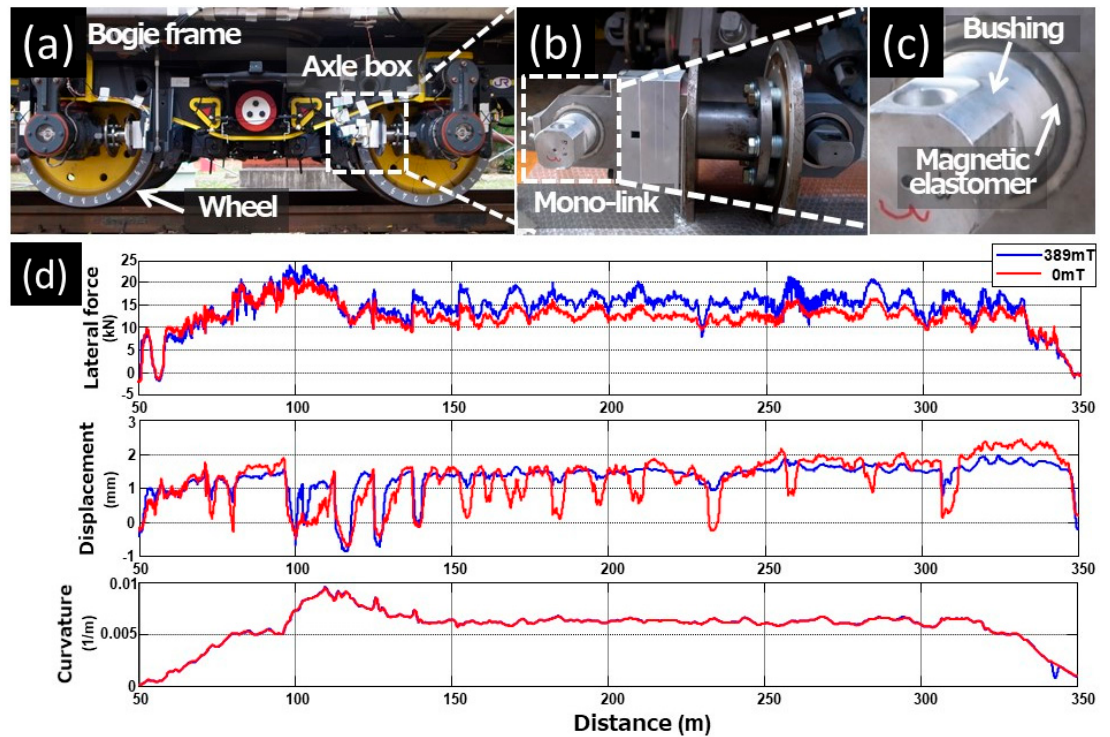
Figure 4. Photographs of ( a ) bogie and ( b , c ) mono-link made of magnetic elastomer containing LP+NP, ( d ) lateral force ( top ), displacement of the magnetic elastomer bushing ( middle ), and curvature ( bottom ) as a function of running distance.